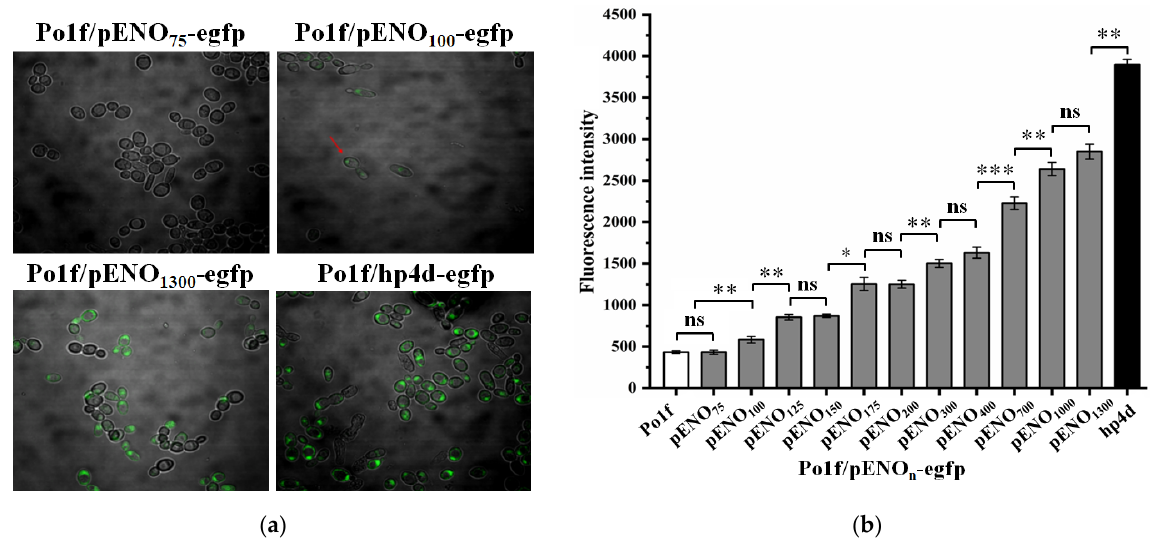
Figure 1. eGFP fluorescence of recombinant strains Po1f/pENO n -egfp harboring different trun- cated enolase promoters pENO n (n = 75, 100, 125, 150, 175, 200, 300, 400, 700, 1000, and 1300 bp). ( a ) Fluorescence detection by laser confocal microscopy. The red arrow represents a cell with fluores- cence; ( b ) fluorescence intensity analysis by flow cytometry. Statistical significance was calculated by unpaired T-test analysis. ns: no significant difference; *: p < 0.05; **: p < 0.01; ***: p <